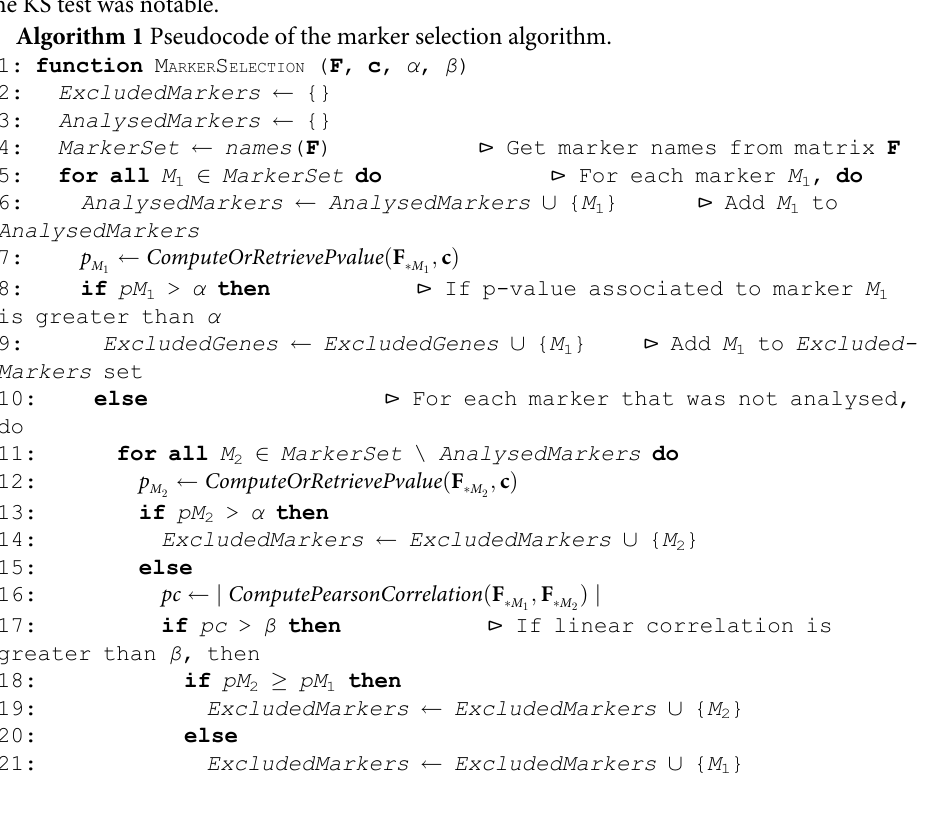
Algorithm 1 Pseudocode of the marker selection